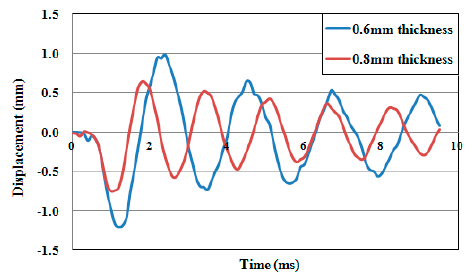
Figure 7. Time series of the out-of-plane displacement of the BGA package ② with fixture I.